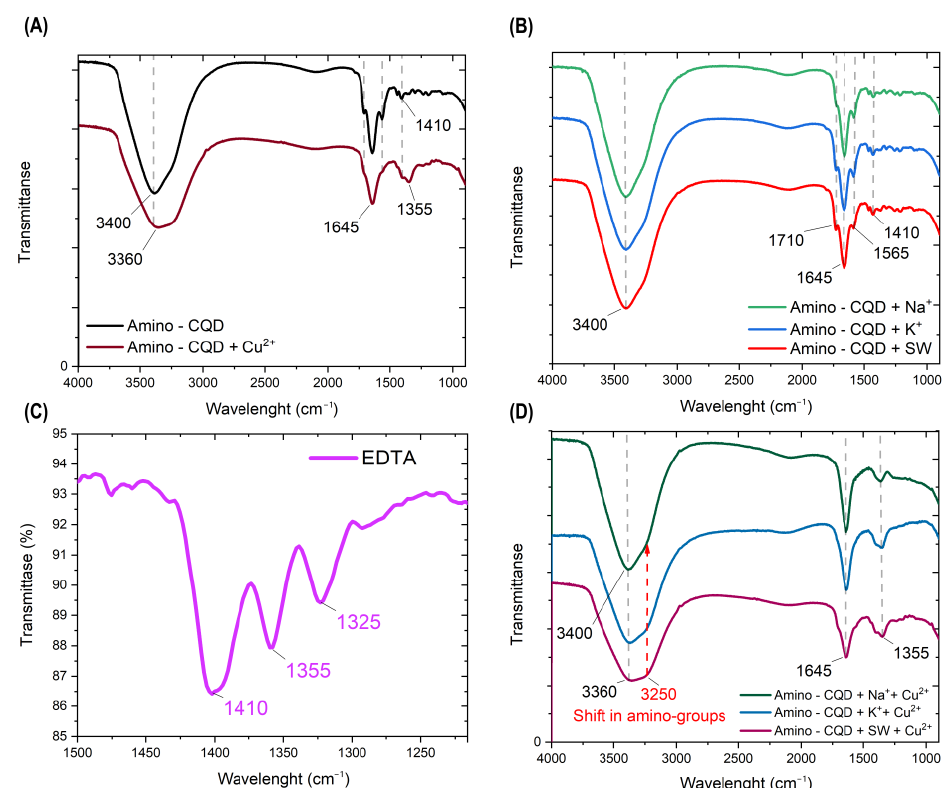
Figure 2. ( A ) The IR spectra of the reaction between Amino-CQD and copper cations, ( B ) Amino-CQD in concentrated alkali ion solution, ( C ) the characteristic line of EDTA in 1250–1500 cm −1 region and ( D ) reaction between Amino-CQD and Cu 2+ in presence of Na + and K + cations. Copper coordination reduced the small peak at 1710 cm −1 (C=O) and 1565 cm −1 (N-H